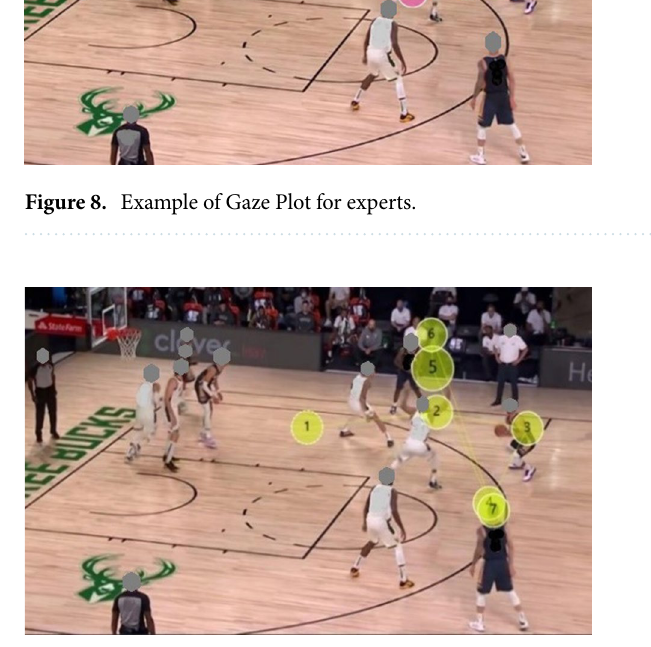
Figure 9. Example of Gaze Plot for novices.